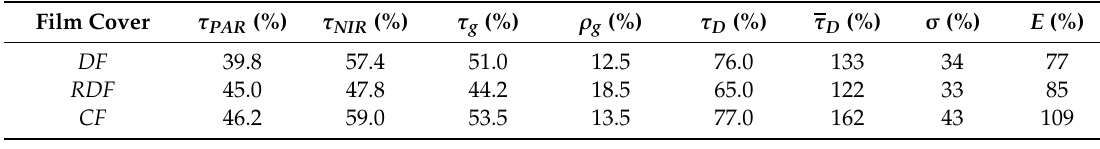
Figure 2. The spectral transmittance ( a ) and reflectance ( b ) measured at normal incidence for the three films used for the study. Table 2. Summary of the main characteristics estimated for the three films tested.